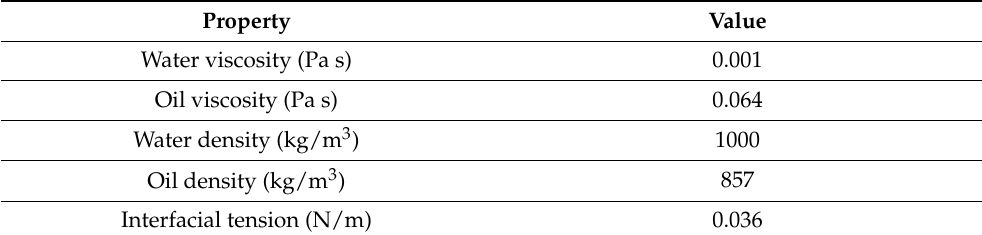
Table 2. Properties of the fluids employed at 15 ◦